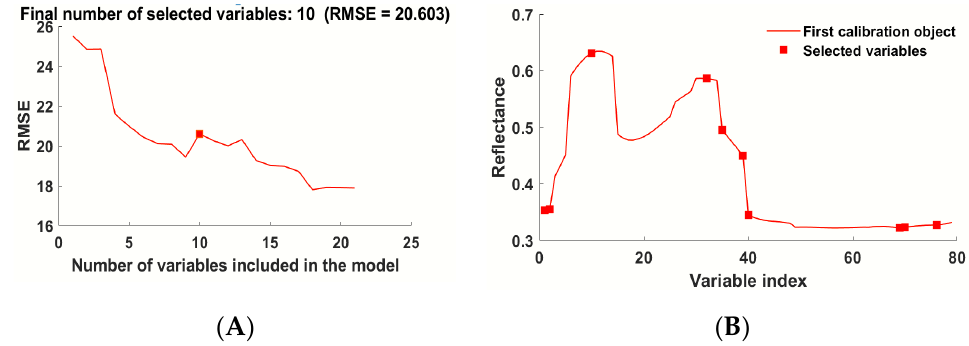
Figure 6. Feature wavelength of IVISSA + SPA extraction; characteristic wavelength of SPA extraction, RMSE plots obtained by IVISSA + SPA ( A ), the bands selected by IVISSA + SPA algorithm ( B ).